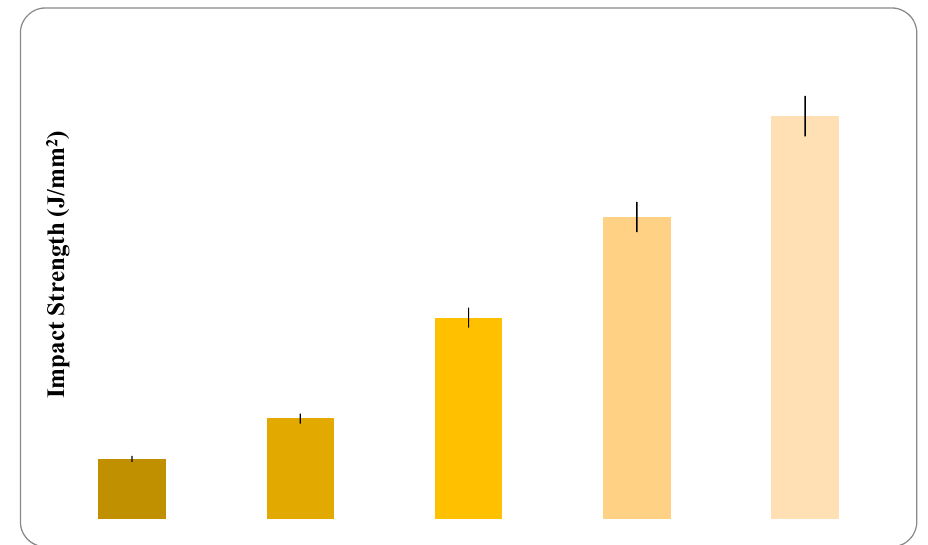
Figure 18. Variation in impact strength with increase in graphene content. Polymers 2021 , 13 , x FOR PEER REVIEW